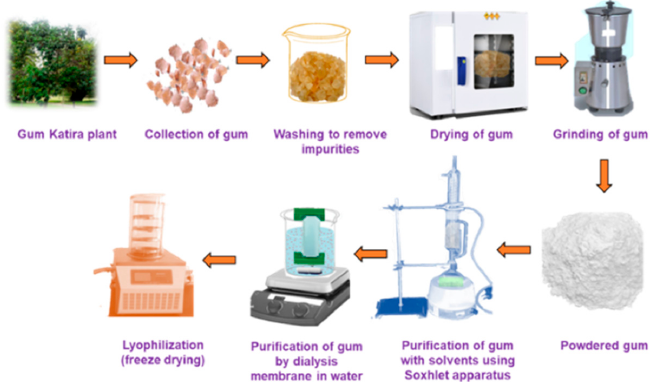
Figure 1. Schematic representation of gum katira collection and purification.